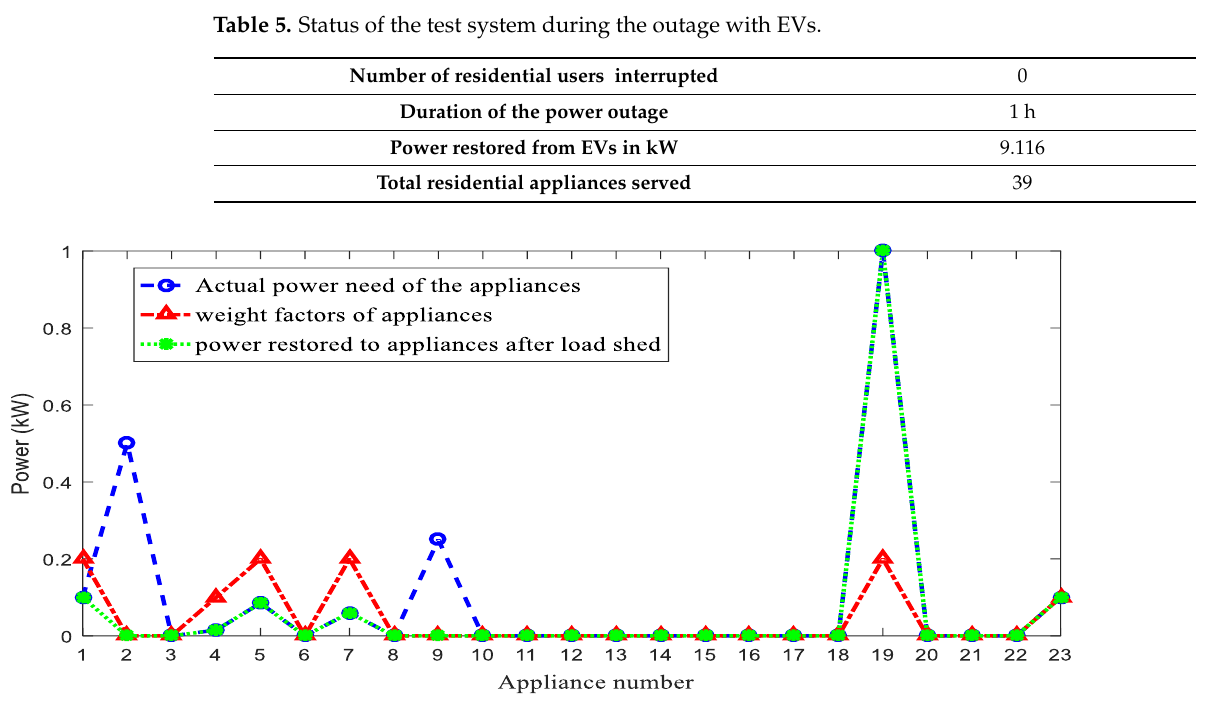
Figure 7. Actual load to meet, weight factors assigned for priority of appliance, and power restored due to EVs for residential user 1.